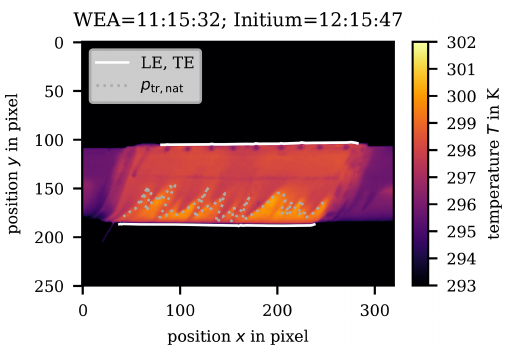
Figure 9. Thermographic picture processed by DWGE. Lead- ing edge (LE) bottom. Trailing edge (TE) further up. The dotted line indicates an automatically recognized transition by the post- processing